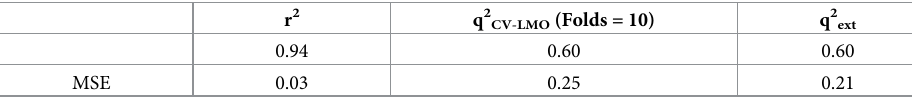
Table 3. Results for the support vector